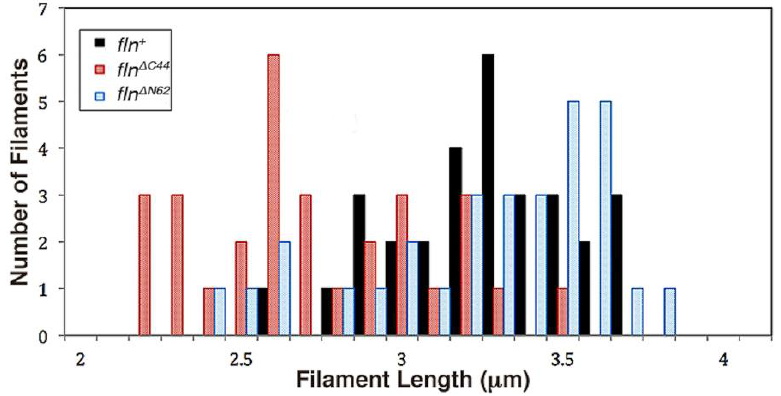
Figure 3. Indirect flight muscle thick filament length distribution amongst transgenic Drosophila . All filaments included fall within a 95% confidence interval of filament length. Table 1. Length parameters of isolated, native thick filaments from Drosophila IFM.